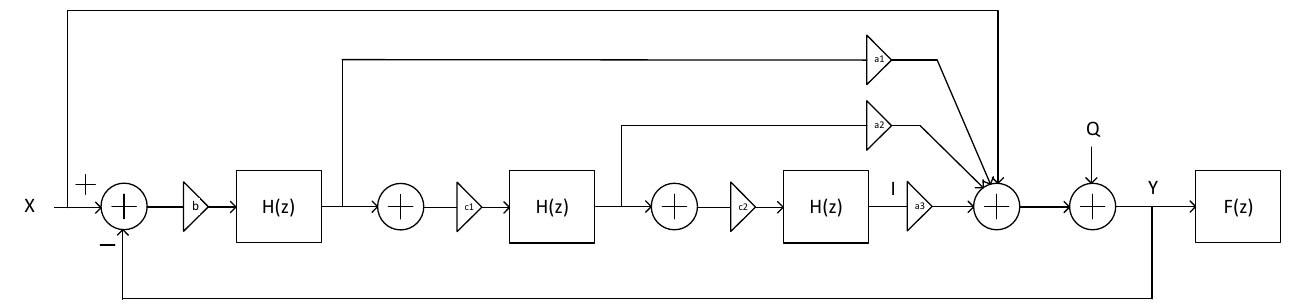
Figure 8. Simplified block level diagram of the 3rd order Feed-Forward (FF) Cascade-of-Integrators (CoI) Single-bit ISD converter system, with all loop coefficients—b, c1, c2 equal to 0.36, in conjunction with feed-forward coefficients, following the rule a1 > a2 > a3, namely 2 > 1 > 0.5 respectively.